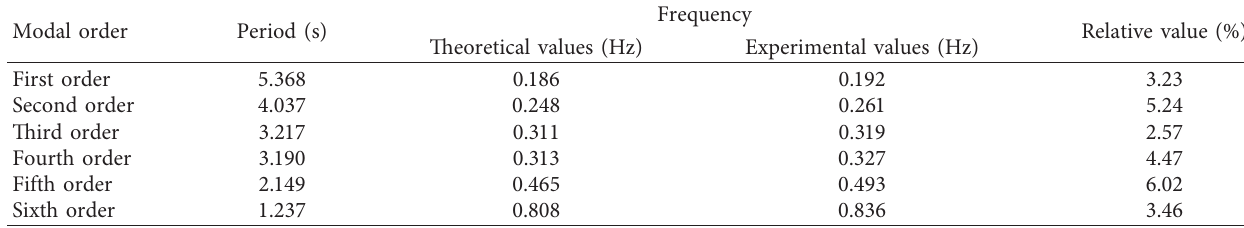
Table 3: Multiorder oscillation modal information of Wolonggou